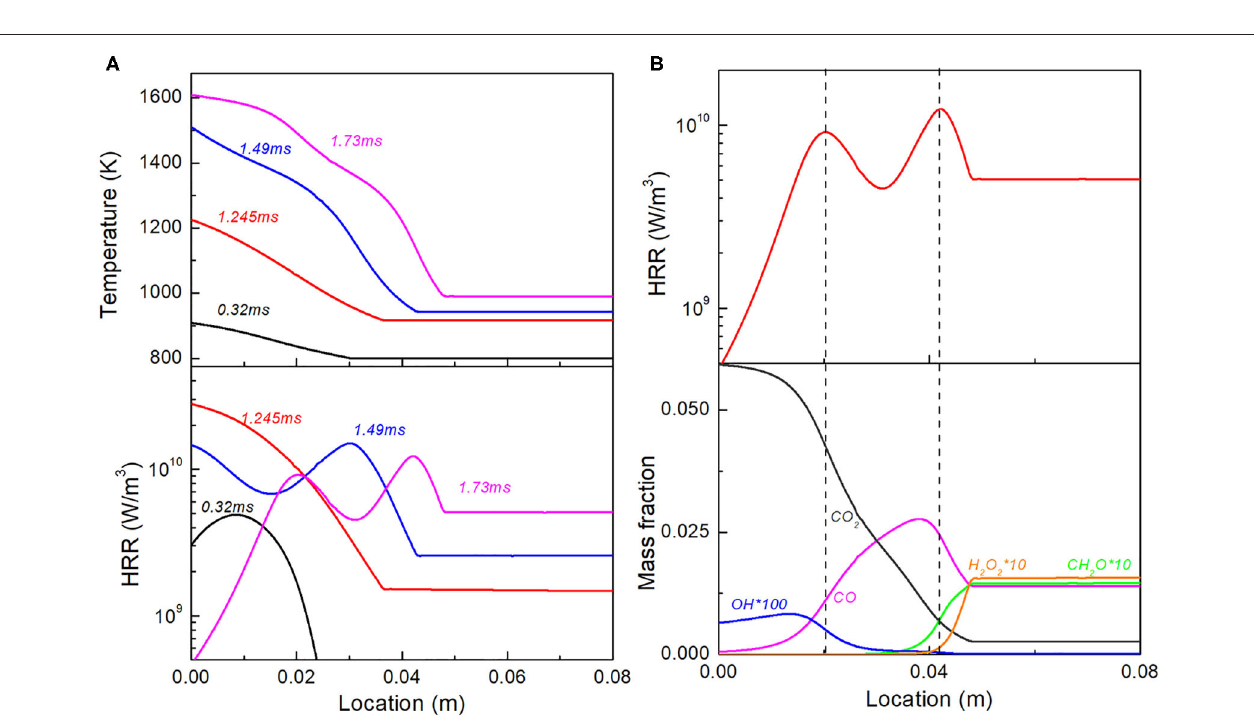
FIGURE 5 | (A) Temperature and heat release rate profile at selected time instants for Case 1; (B) Double peak heat release and profiles of representative species for reaction front at t =